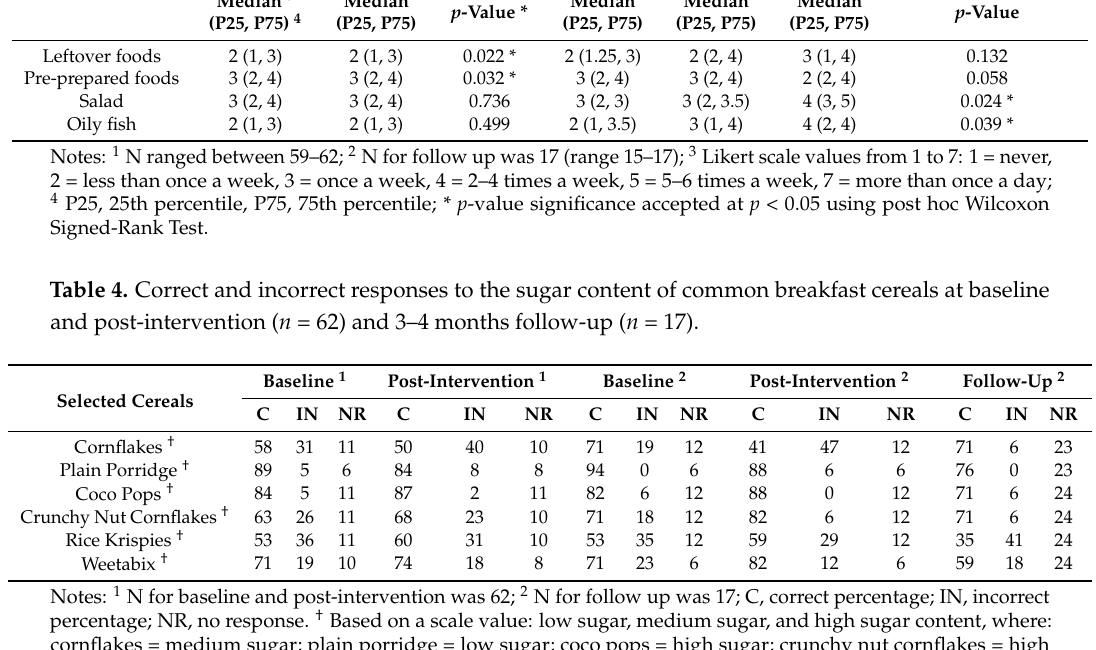
Selected Food Items